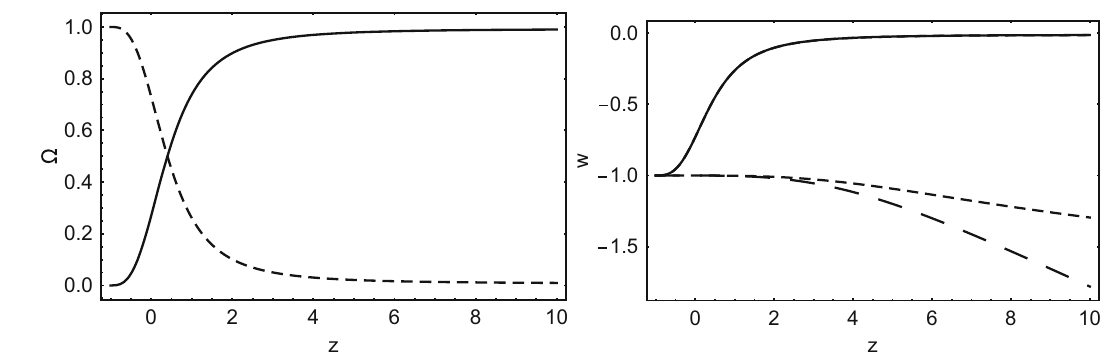
ν w de , but for a larger value of G , in such a way that we now have ν = 1 × 10 − 3 . At the present time, at z = 0, they take the values G (cid:6) (cid:10) 0 . 73, (cid:6) = 0 . 27, w (cid:10) − 1, and w (cid:10) − 1. Asymptotically, de dm de T the model approaches to an attractor fixed point which is a de Sitter dark energy dominated solution with (cid:6) de = 1, (cid:6) dm = 0, w de = − 1, and w T = − 1